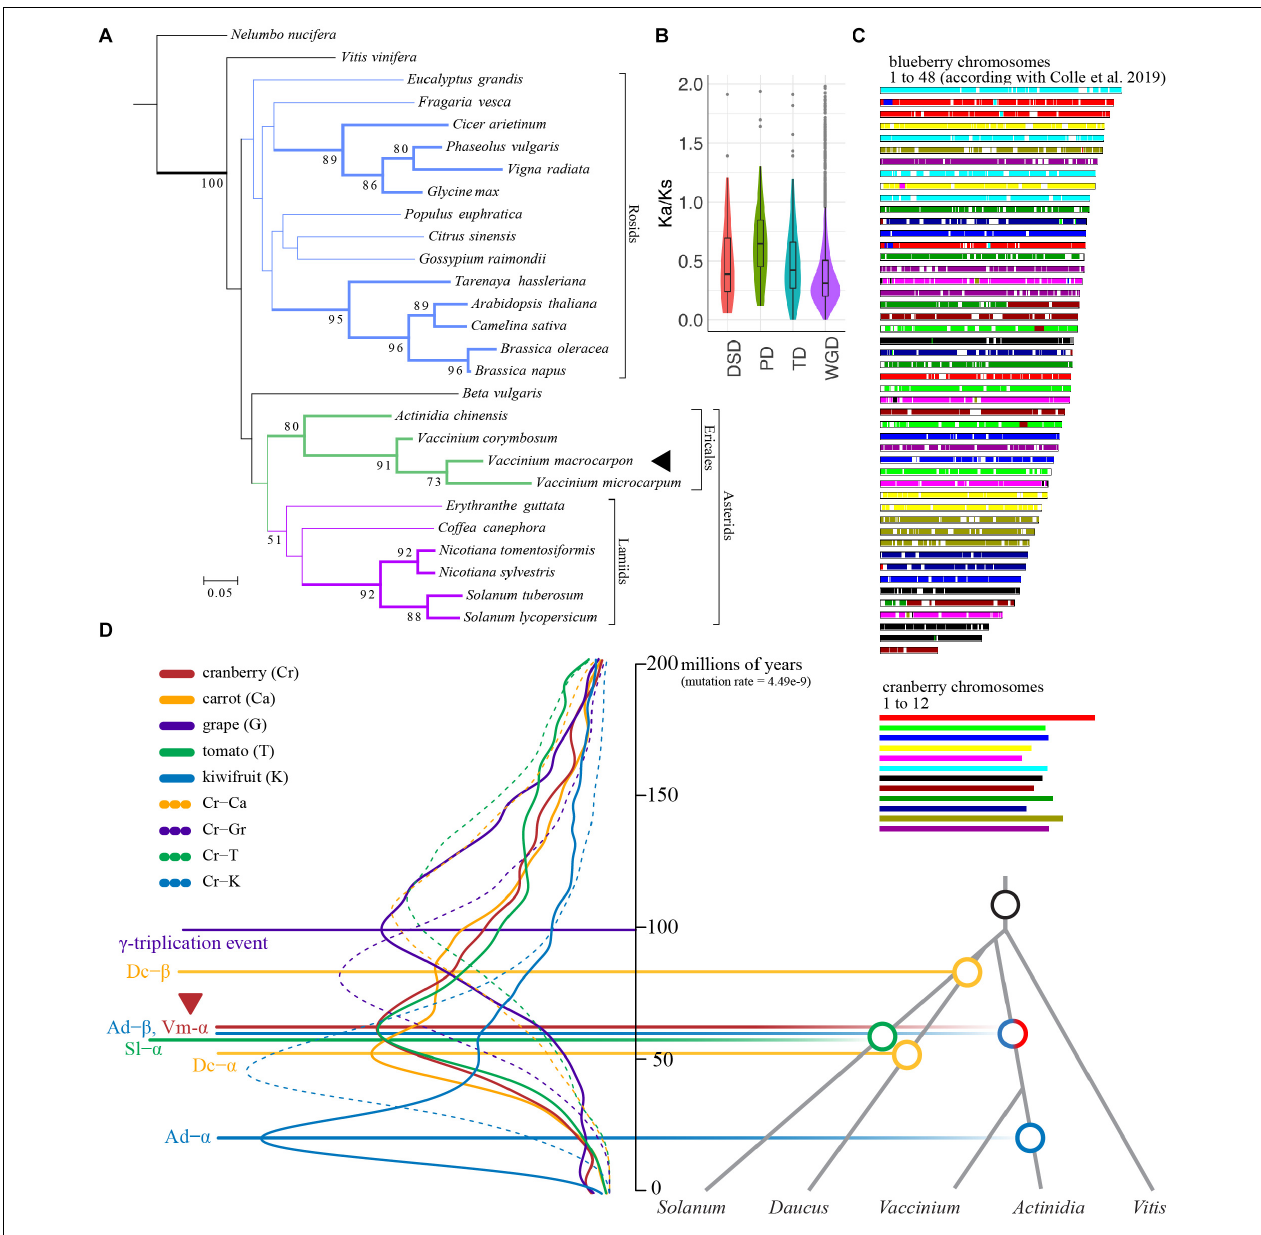
FIGURE 2 | The American cranberry ( Vaccinium macrocarpon Ait.) genome evolution. (A) Phylogenomic analysis for 27 species and 6,327 orthogroups. Only bootstrap values larger than 50 are shown. Nodes supported by bootstraps > 70 are shown as tick bars. (B) Ka/Ks ratio distributions of gene pairs grouped by four different types of duplication (WGD, whole genome duplication; TD, tandem duplication; PD, proximal duplication; DSD, dispersed duplication). In the boxplots, points represent outliers; the center line is the mean; lower and upper hinges are 25th and 75th percentiles. (C) Schematic representation of the collinearity between cranberry and tetraploid blueberry (chromosome sizes between species are not scaled). (D) Distribution of the synonymous substitution (Ks) rate for collinear genes from cranberry ( Vaccinium macrocarpon ), carrot ( Daucus carota ), grape ( Vitis vinifera ), tomato ( Solanum lycopersicum ) and kiwifruit ( Actinidia chinensis ). Solid and dashed lines represent intra and inter species comparisons, respectively; Ks estimates were converted to millions of years using T = Ks/2r , where r = 4.49 - 9 (Wei et al., 2018; Wu et al., 2019).